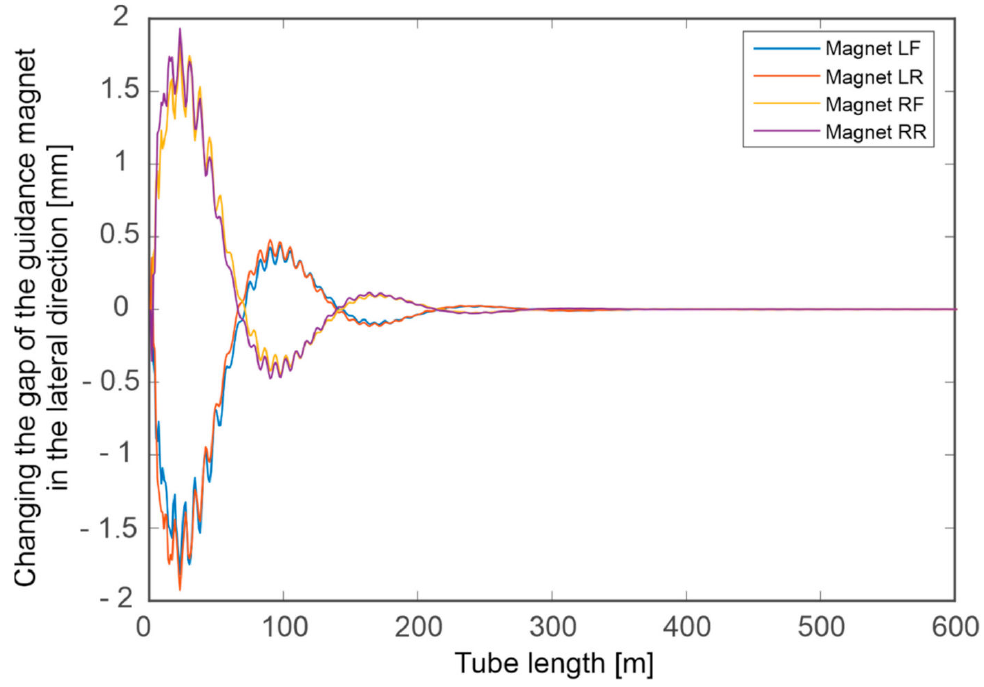
Figure 12. Change in the gap width on the guidance magnet in the lateral direction resulting from the capsule speed of 2000 km / h.